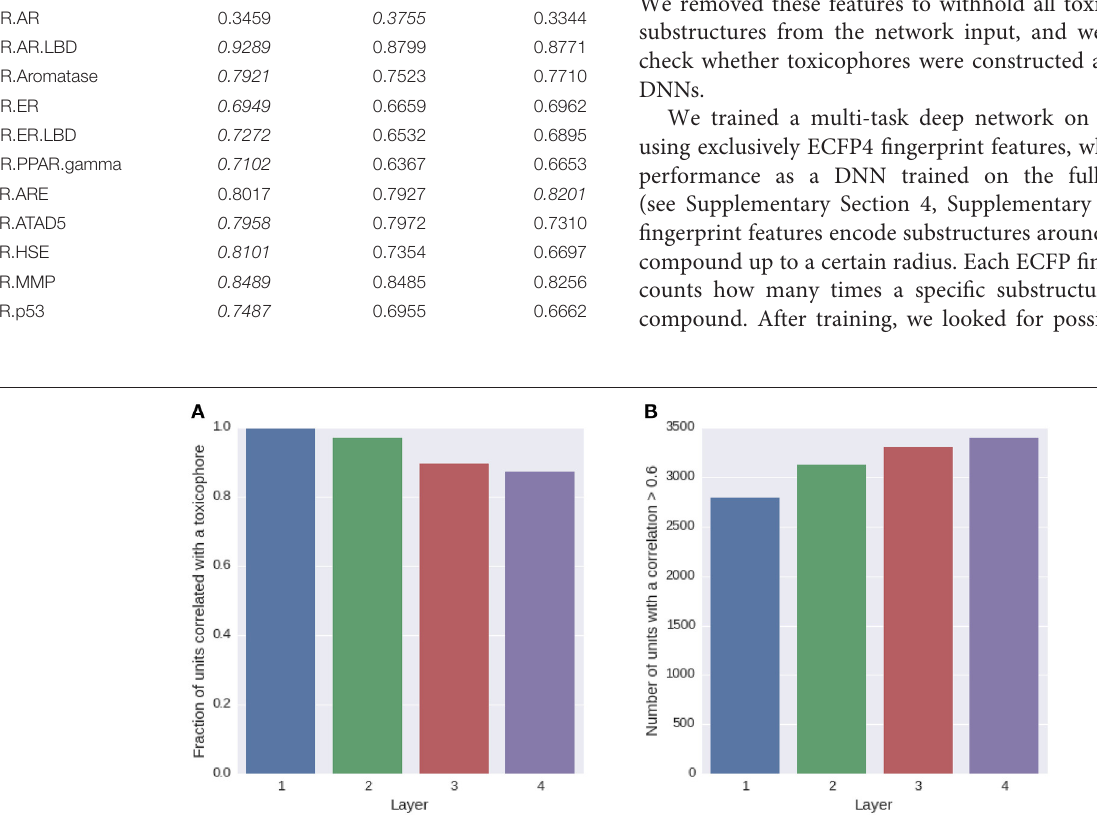
Frontiers in Environmental Science |